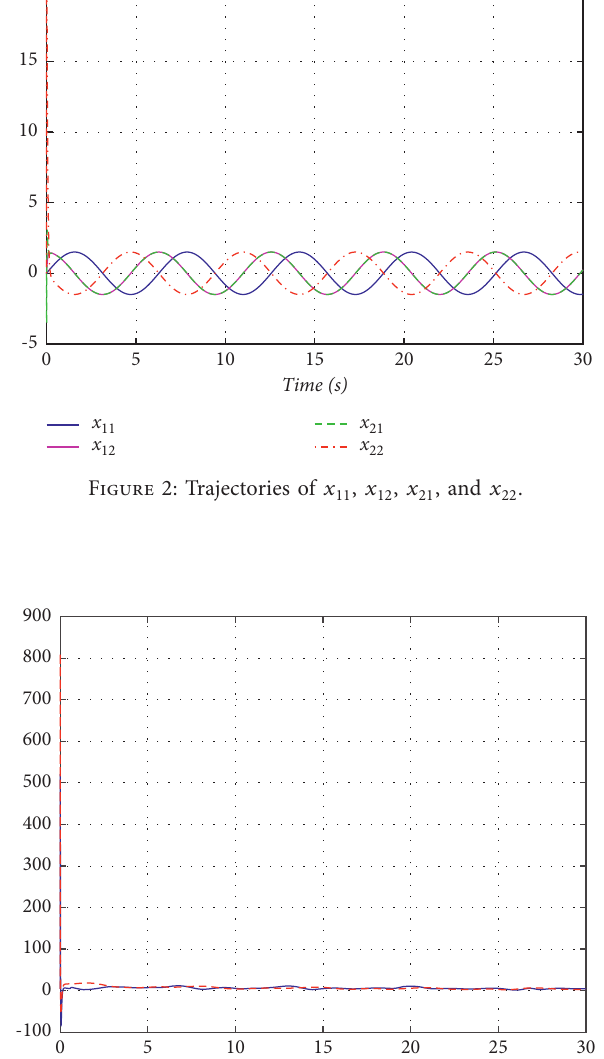
Figure 3: Trajectories of u